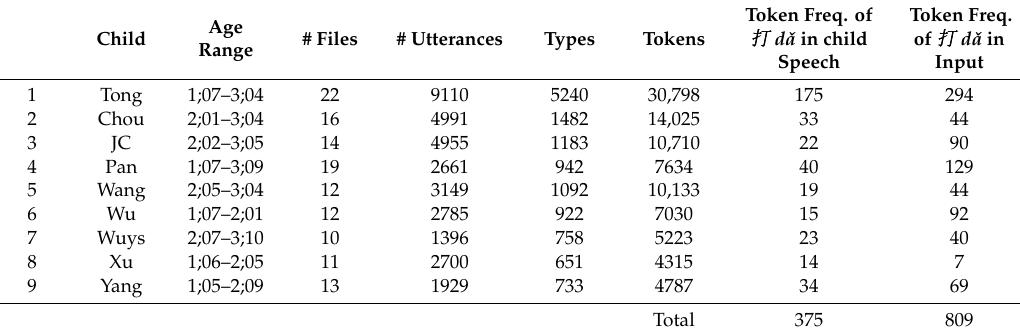
Table 2. Information about the target children in the longitudinal naturalistic corpora.